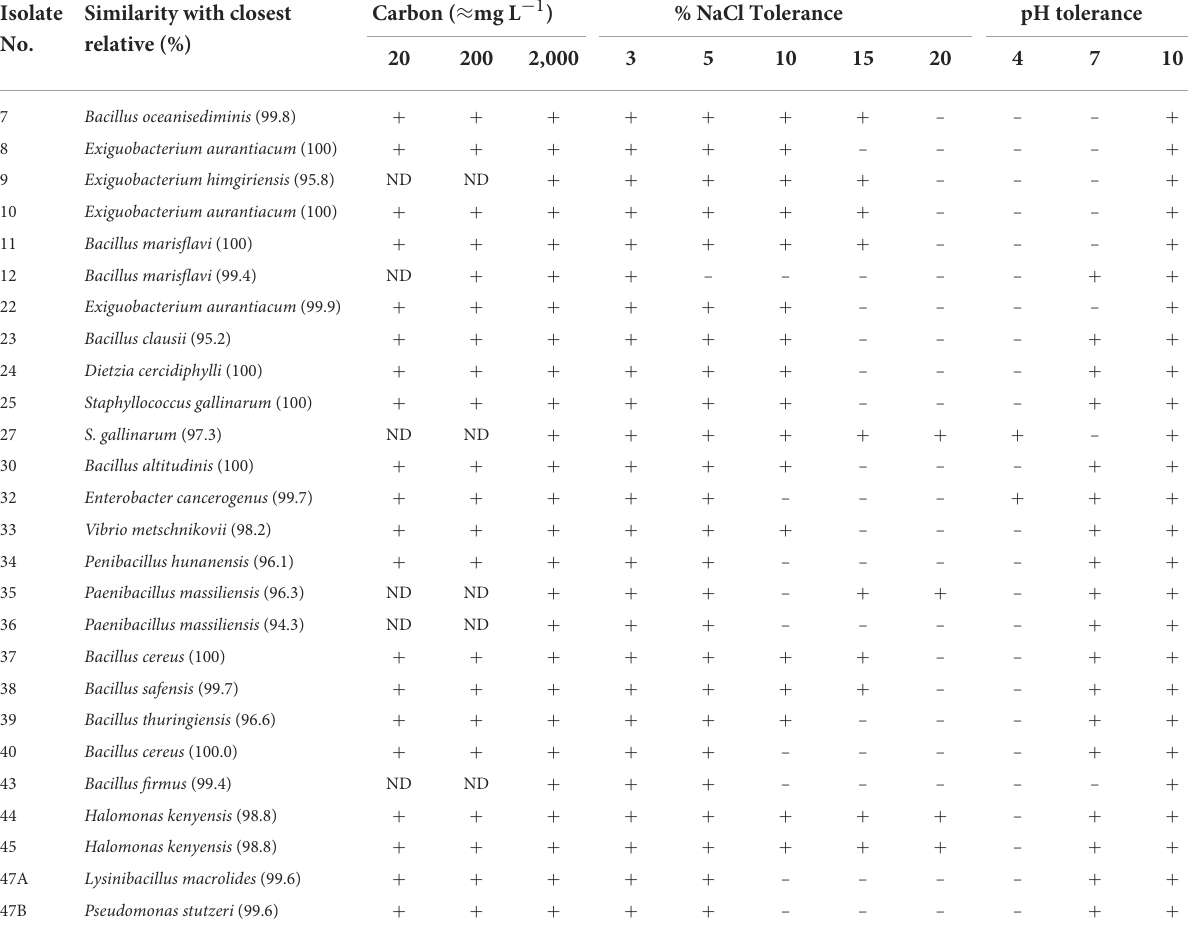
TABLE 2 List of facultative oligotrophs and their physiological growth response on different levels of carbon, NaCl, and pH. Isolate Similarity with closest No.